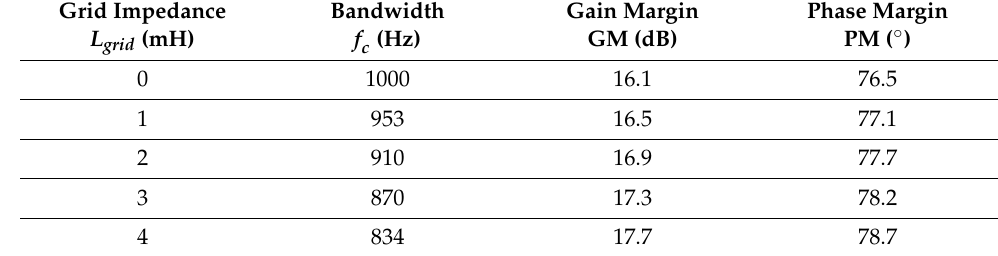
Table 2. Stability Analysis of Single-loop PI Control for the L Filter Type GcI.